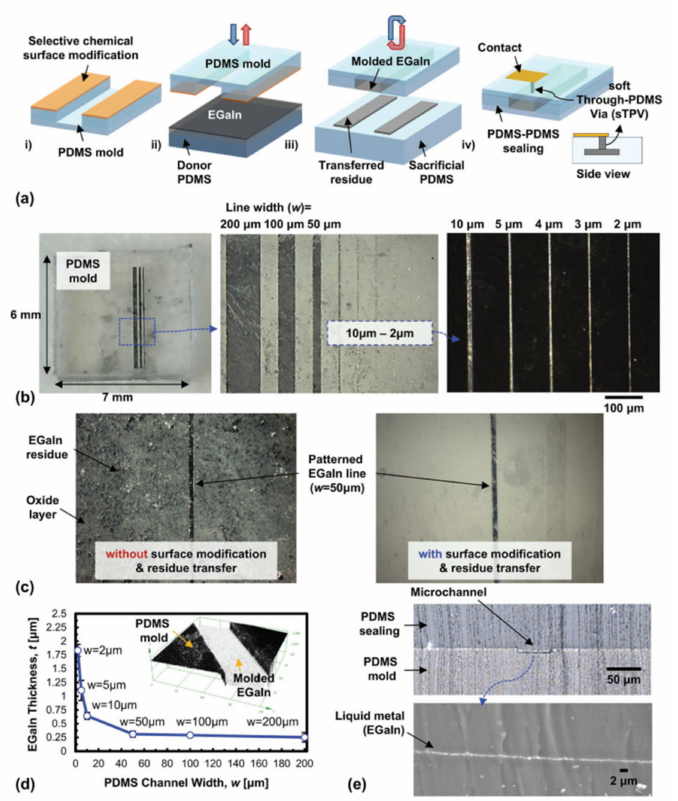
Figure 5. ( a ) Patterning process of EGaIn thin-line fabrication. ( b ) The widths of EGaIn lines from 2 µ m to 200 µ m with channel spacings of 100 µ m. ( c ) The Patterned EGaIn line and surrounding PDMS surfaces with and without chemical surface modification and residue transfer technique for residue-free surfaces. ( d ) Measured EGaIn thickness inside of a PDMS mold as a function of PDMS channel width. ( e ) Cross-sectional view of EGaIn molded microchannel (top) and enlarged view of EGaIn molded thin film (bottom). Reprinted with permission from Ref. [3]. Copyright 2016 John Wiley and